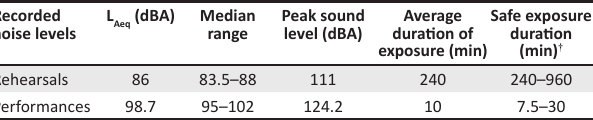
TABLE 2: Sound levels that (dBA) musicians were exposed to during rehearsals and performances. Recorded L (dBA) Median Aeq noise levels range